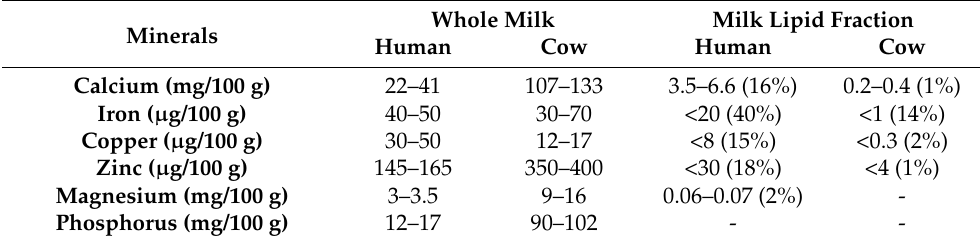
Table 4. Distribution of minerals in whole milk and in milk lipid fraction of human and cow’s milk. Data from Zamberlin et al. (2011) [52], Mulder and Walstra (1974) [63], Fransson and Lonnerdal (1983) [64], Soliman (2005) [65], Walton and Flynn (2013) [66], Chassaing et al. (2016) [67] and Pietrzak-Fie´cko and Kamelska-Sadowska (2020)